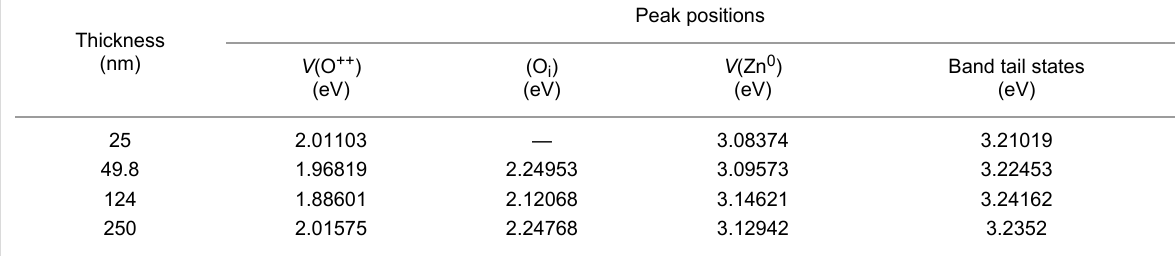
Table 2: Positions of absorption and PL peaks of ZnO thin films of different